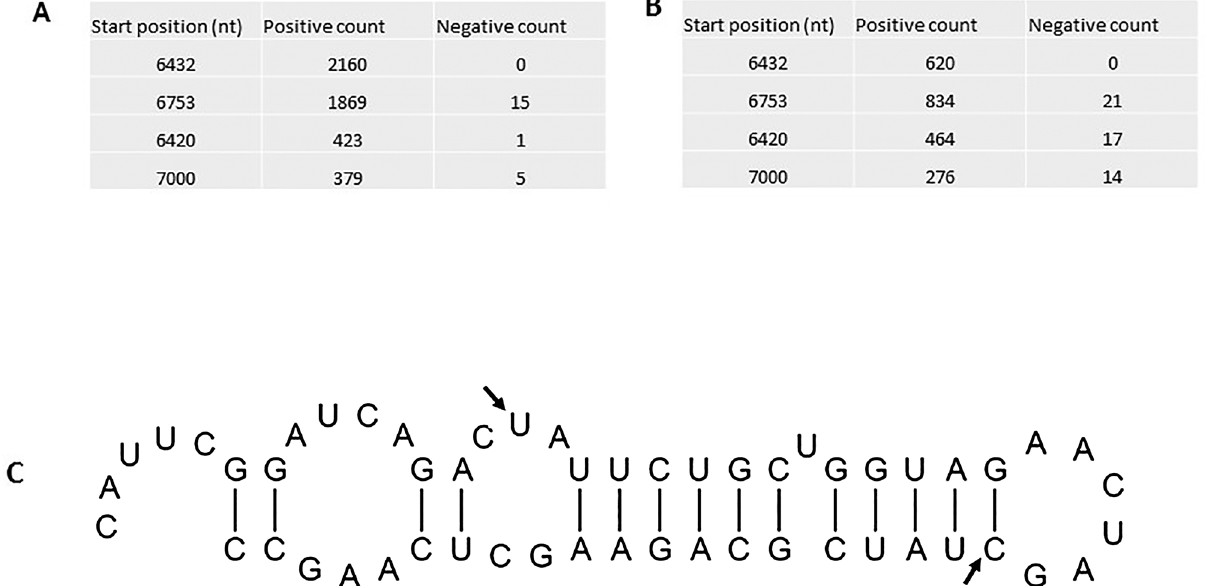
Fig 6. The silencing hot spots of TaBCHV-1(A) and TaBCHV-2(B) genomes and the predicated secondary structure around the vsRNA at 6432 nt (C). The start and stop positions of the vsRNA 6432 are marked by bold arrows.